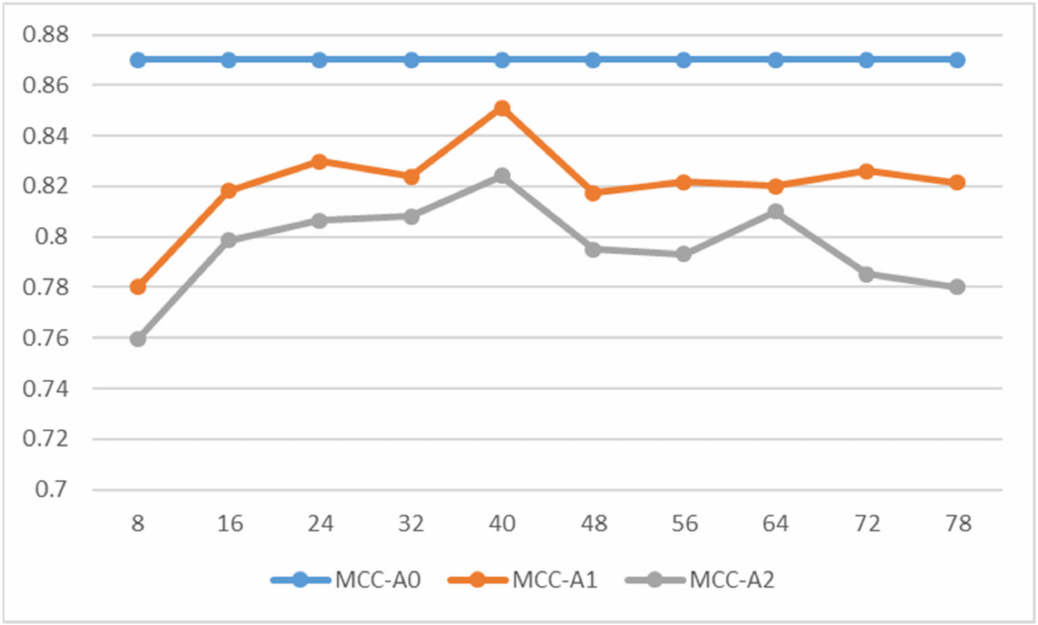
Figure 8. PCB dataset: MCC for A0, A1, and